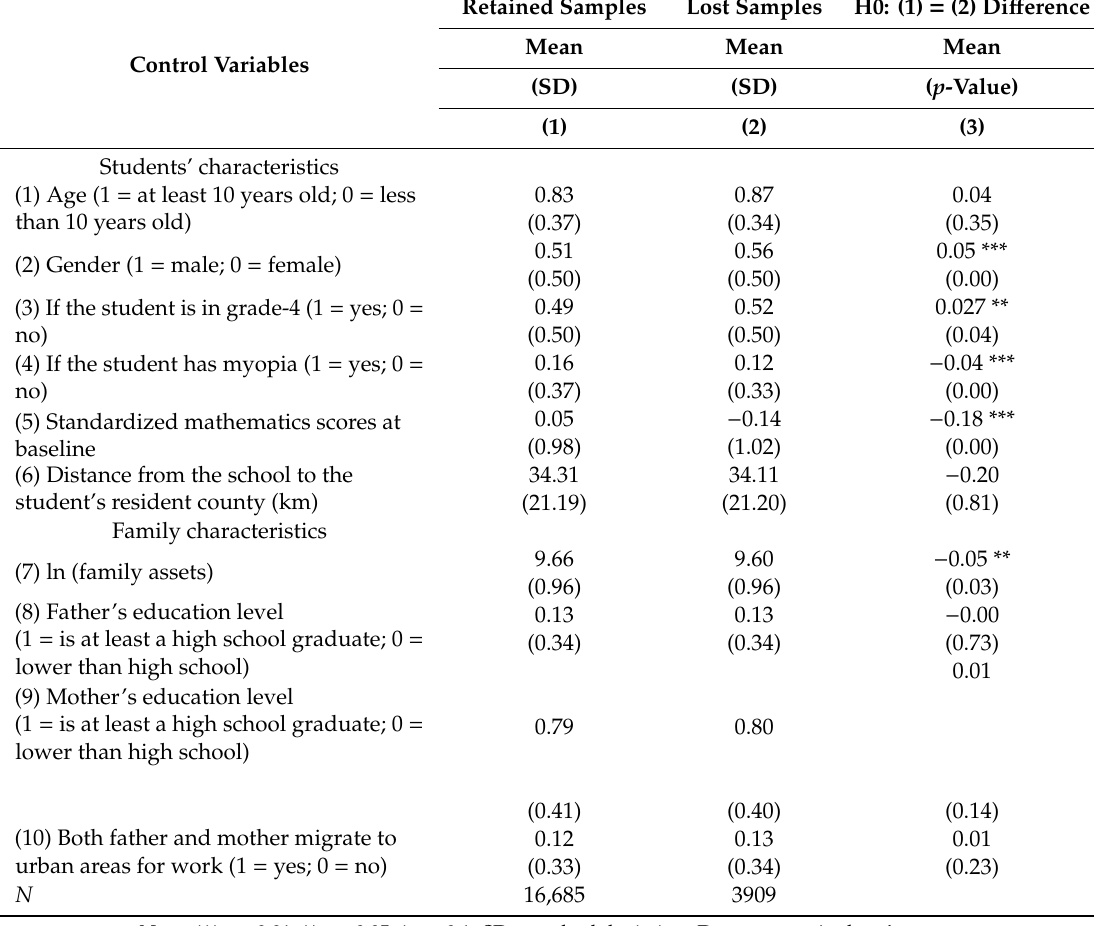
Table 1. Comparison of the characteristics of students between retained samples and lost samples.